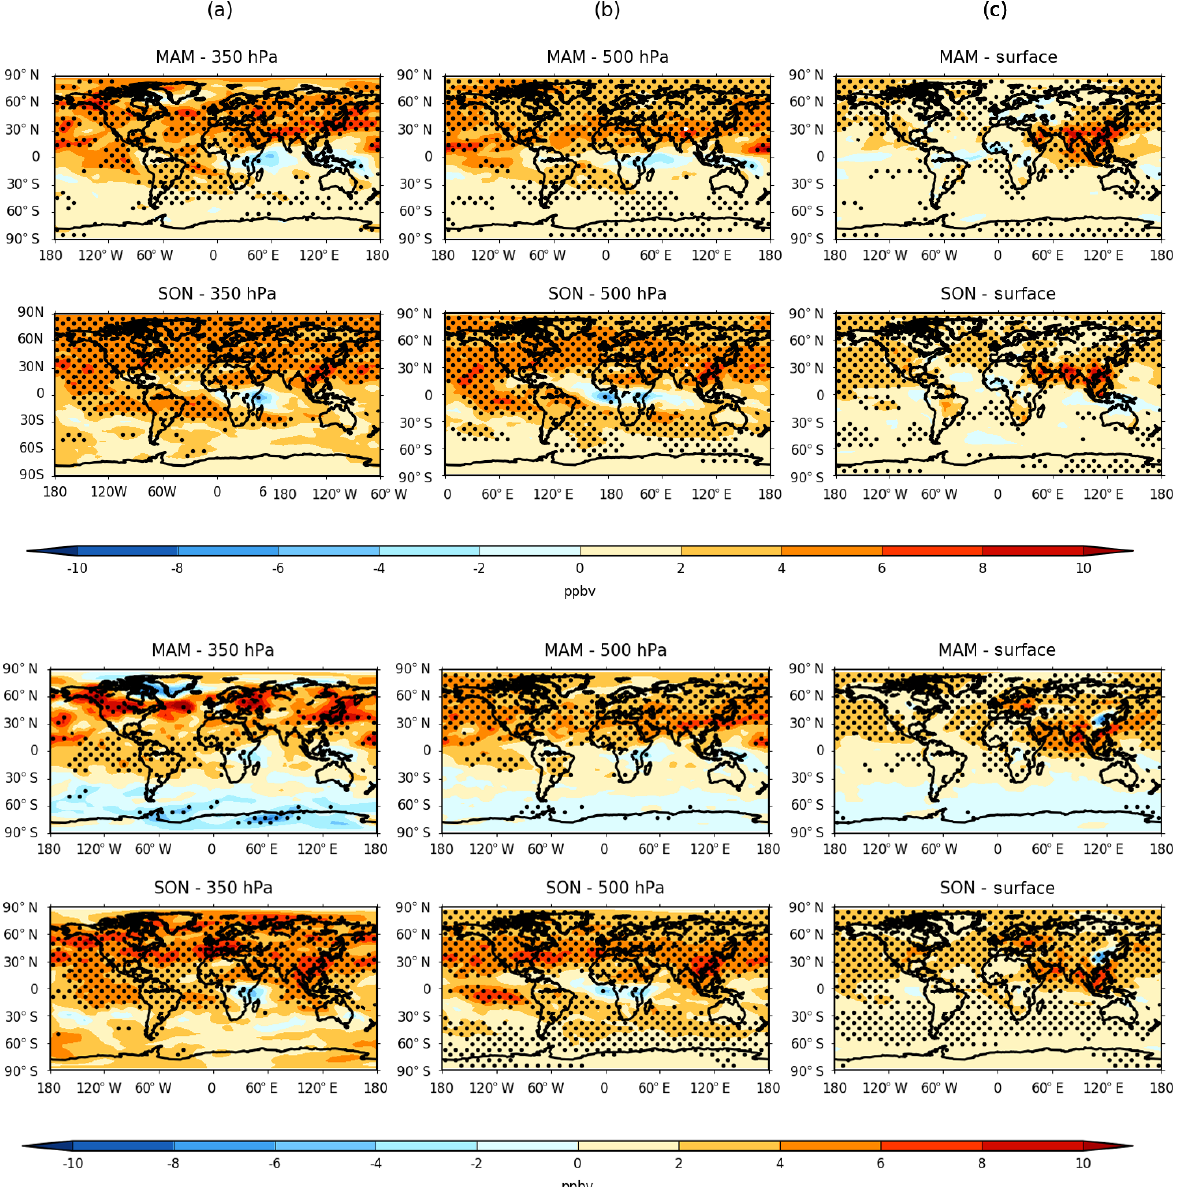
Figure 8. Seasonal change in EMAC (top) and CMAM (bottom) ozone (O 3 ) VMR (ppbv) between 1980–1989 and 2001–2010 for MAM and SON at (a) 350hPa, (b) 500hPa and (c) the surface model level. Stippling denotes regions of statistical significance according to a paired two-sided t test ( p < 0 .